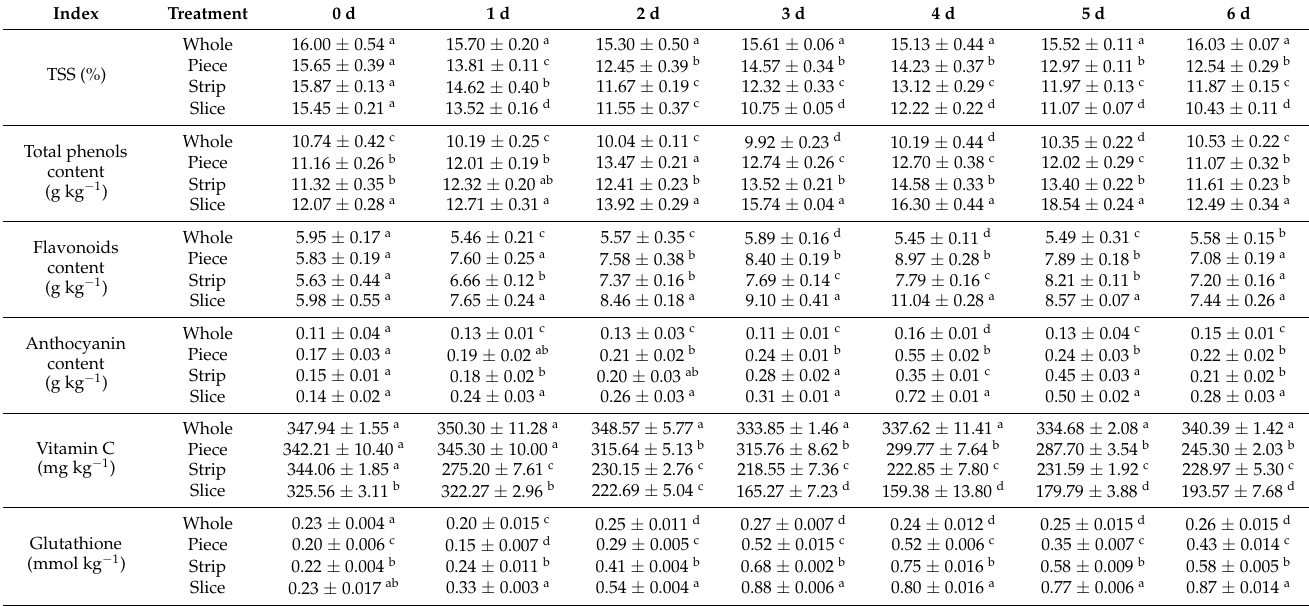
Table 1. Influence of wounding intensities on the quality of fresh-cut